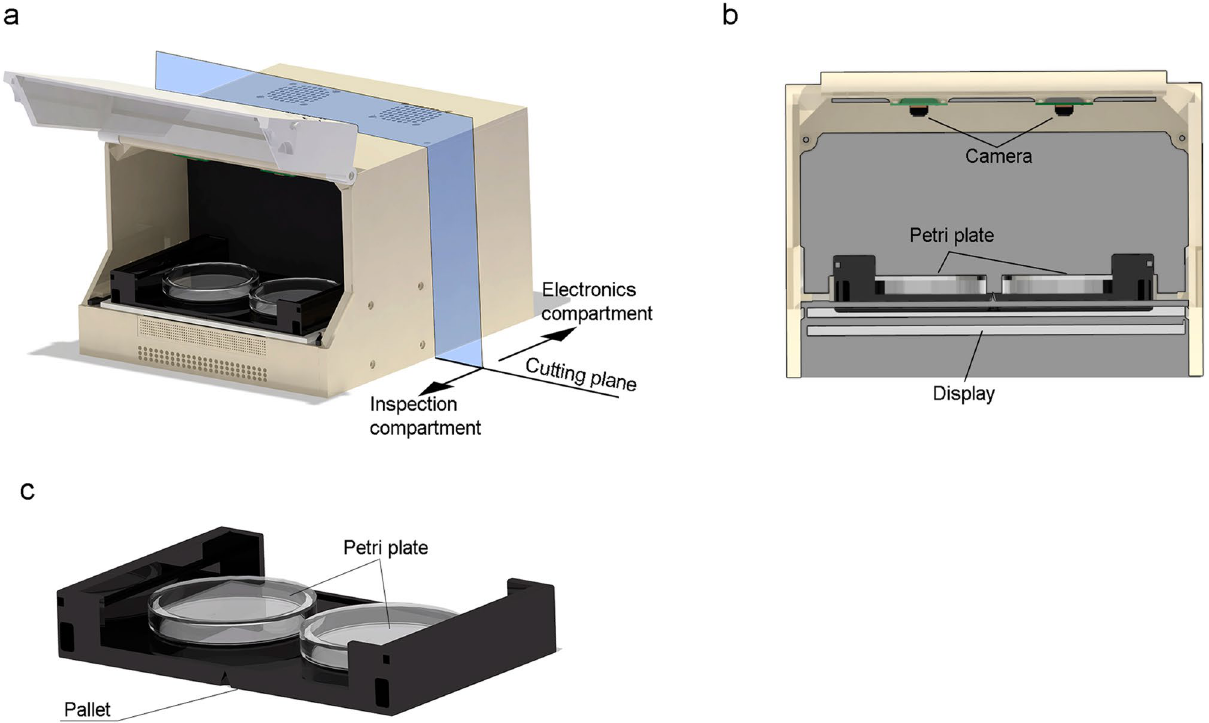
Figure 1. Prototype of the SiViS device. The image was obtained with SOLIDWORKS 2020 SP3.0. ( a ) SiViS with the open door, showing the pallet inside the inspection area. The electronic compartment, at the back, is closed and therefore hidden from view. ( b ) Section showing the inspection area and the distribution of the components. ( c ) Pallet with two slots for the Petri